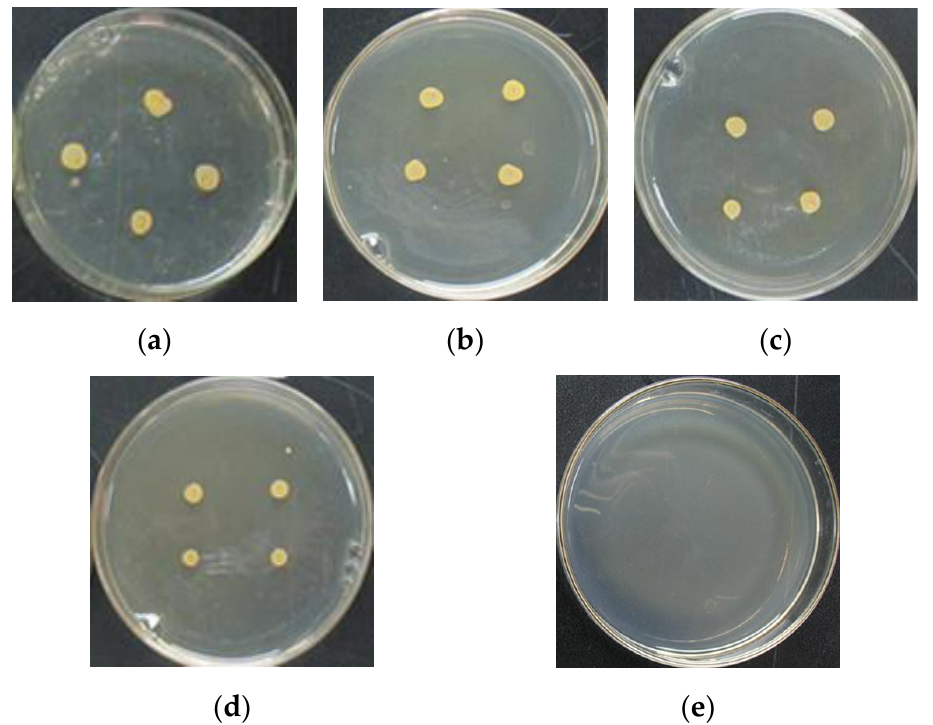
Figure 11. Appearance of colonies of Staphylococcus aureus after treatment with CMC, QCMC , Ag NPs and QCMC-Ag at a concentration of 0.005%: ( a ) blank; ( b ) CMC; ( c ) QCMC; ( d ) Ag NPs and ( e ) QCMC-Ag. Table 1. Minimum inhibition concentrations (MICs) of CMC, QCMC, Ag NPs and QCMC-Ag; the concentration of silver released from Ag NPs and